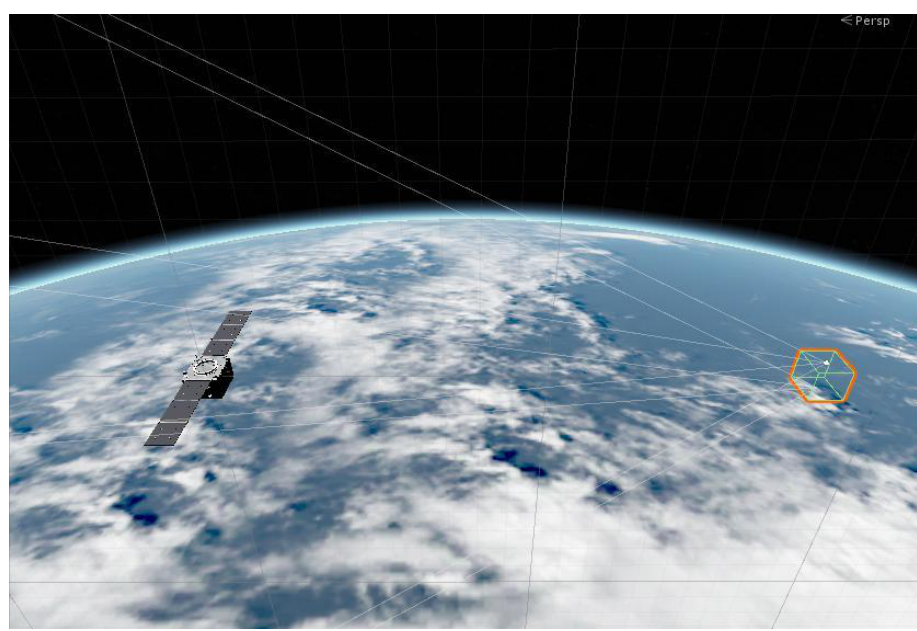
Figure 12. Simulation scene.